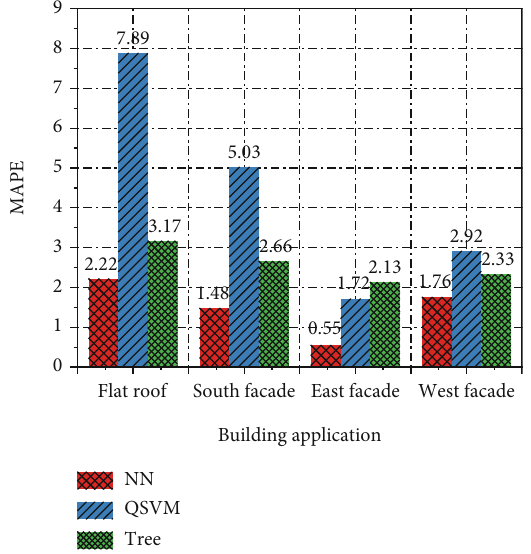
Figure 11: Mean absolute percentage error of predicted